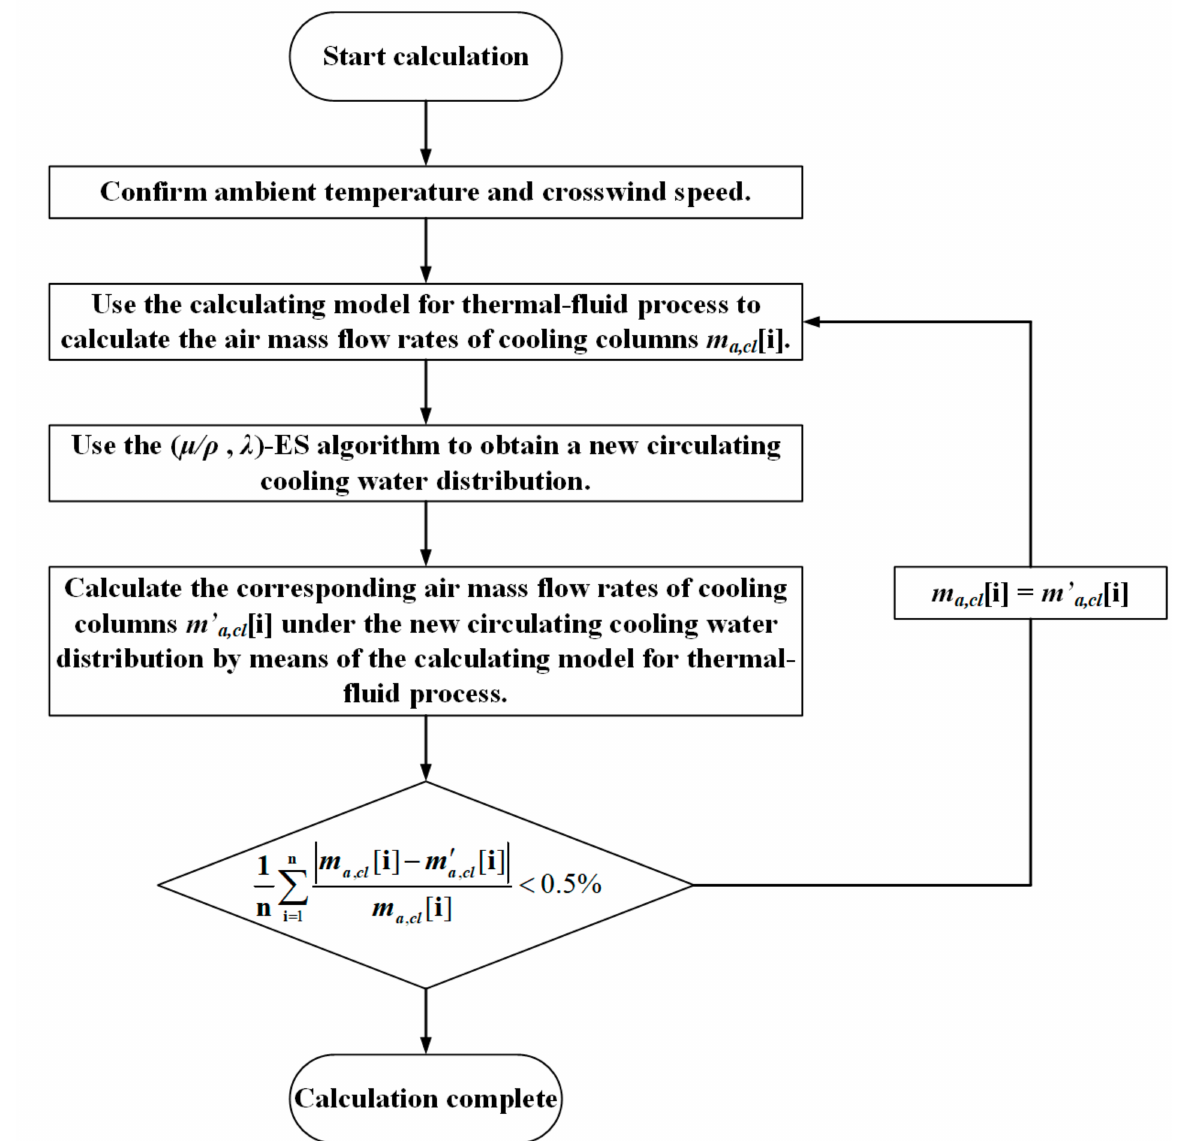
Figure 7. Flow chart of the comprehensive calculation